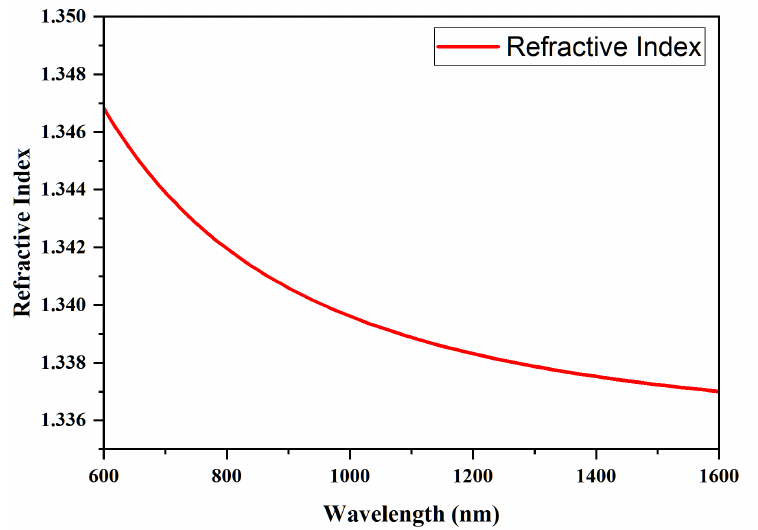
Figure 1. Variation of the refractive index of plasma with a wavelength of the signal. Table 1. Effect of water concentration in changing hematological parameters [4]. Hematologic Parameters